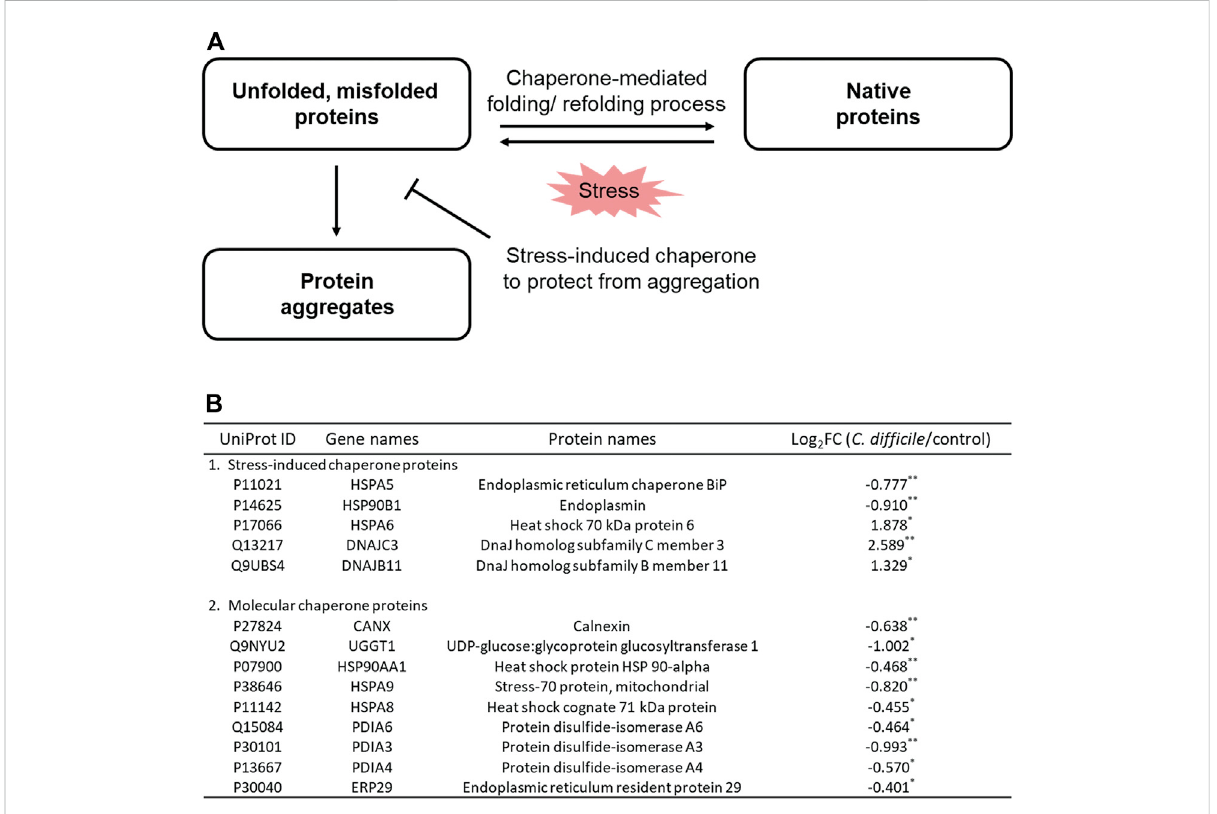
FIGURE 6 (A) Mechanismsofproteinfoldingandrefoldingbychaperonesinresponseto C.dif fi cile -inducedcellularstress. (B) Tableofproteinsbelonging to thecellular chaperonefamily of Caco-2 cells cultured with C. dif fi cile . Proteomic analysis wasperformed intriplicate. * p < 0.05, ** p < 0.01, *** p <